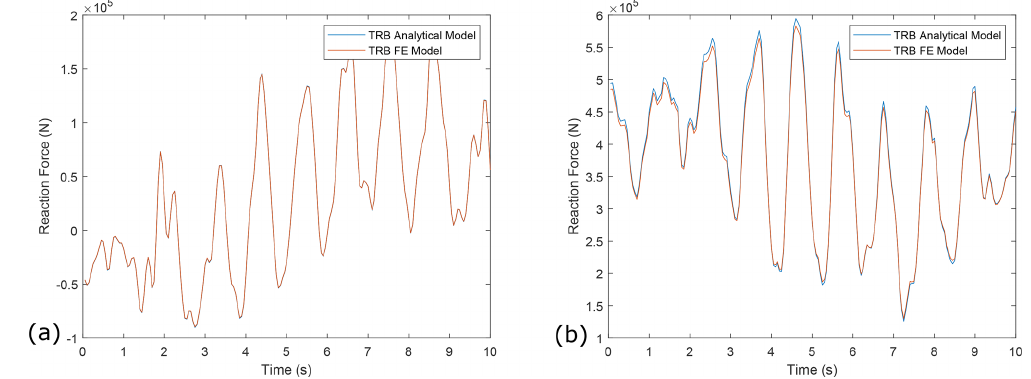
Figure 17. (a) Example time series of reaction force results in the horizontal plane from the analytical DTRB (with torsional springs) and DTRB FE models. (b) Example time series of reaction force results in the vertical plane from analytical DTRB (with torsional springs) and DTRB FE models.